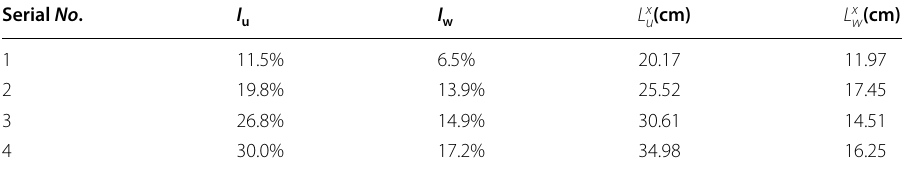
Table 1 Average value of the fluctuating features of four kinds of flow fields (incoming wind velocity U 4 m/s-9 m/s) = Serial No